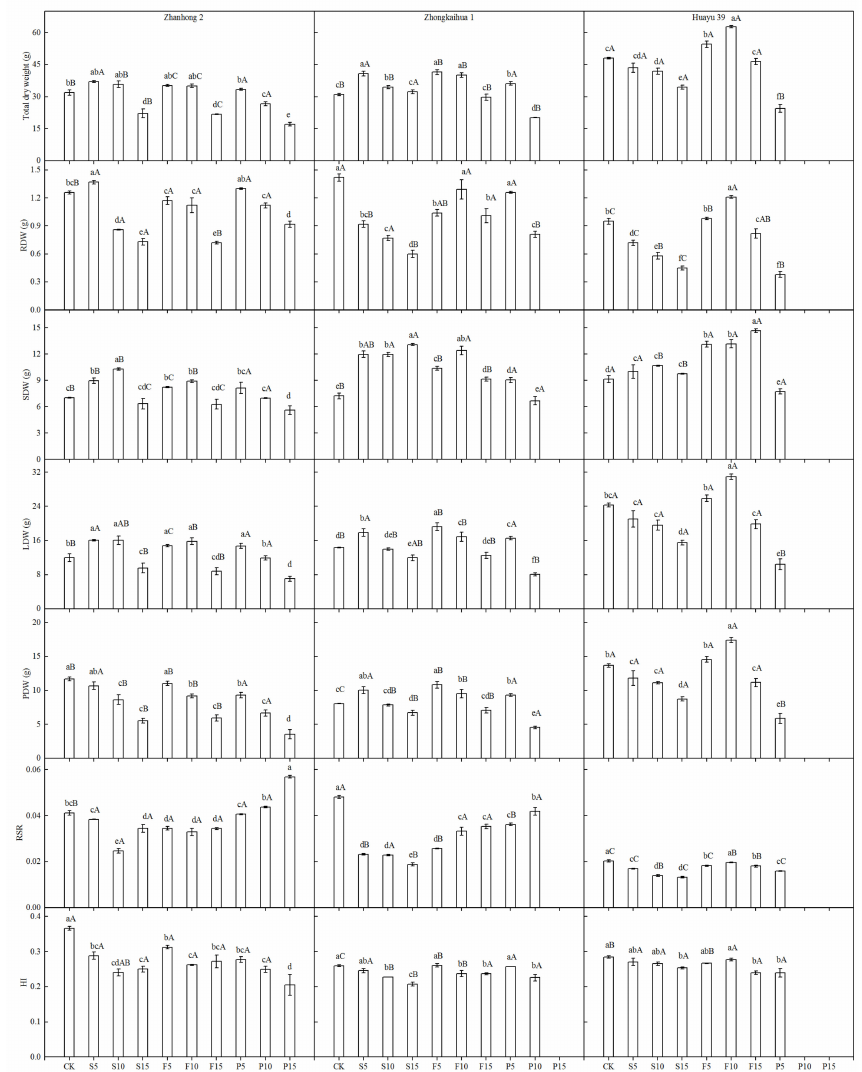
Figure 3. E ff ect of waterlogging on dry matter accumulation at the harvest stage. Note: data are presented as the average value ( n = 3). Di ff erent lowercase letters indicate statistically significant di ff erences between waterlogging stress treatments ( p < 0.05) in the same ecotype, as determined by the least significant di ff erence test. A, B, and C indicate statistically significant di ff erences between di ff erent ecotypes under the same waterlogging stress treatments ( p < 0.05), as determined by the least significant di ff erence test. CK: control (plants without waterlogging stress); treatments: plants with waterlogging stress. S5, S10, S15, F5, F10, F15, P5, P10, P15 indicate the waterlogging stress for 5, 10, and 15 days at the seedling, flowering, and pod-filling stages, respectively; TDW: total dry weight; RDW: root dry weight per plant; SDW: stem dry weight per plant; LDW: leaves dry weight per plant; PDW: pod dry weight per plant; RSR: root-shoot ratio; and HI: harvest